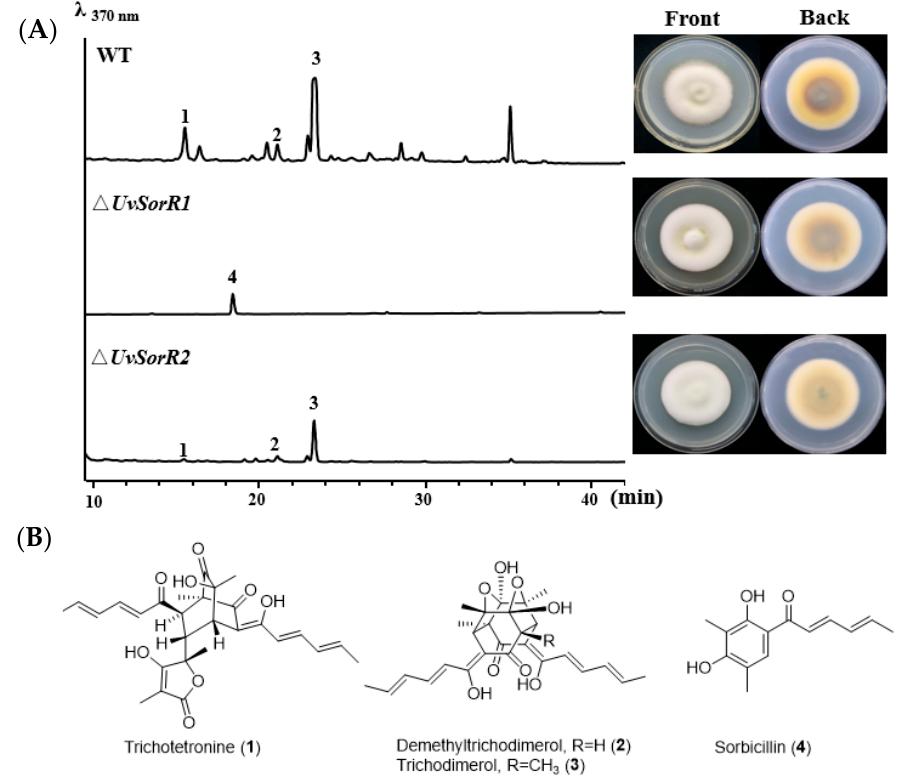
Figure 7. Colony morphologies and HPLC profiles of sorbicillinoids from the WT strain and two specific transcription factor deletion mutants. ( A ) HPLC profiles of the WT strain, ∆ UvSorR1 and ∆ UvSorR2 mutants detected with UV at 370 nm (left panel). All tested strains were cultured at 28 °C for 28 days on GYES medium for sorbicillinoid test. The colony morphologies was observed after 28 days of culture on the PDA plates (right panel). ( B ) Chemical structures of sorbicillinoids 1 – 4 .